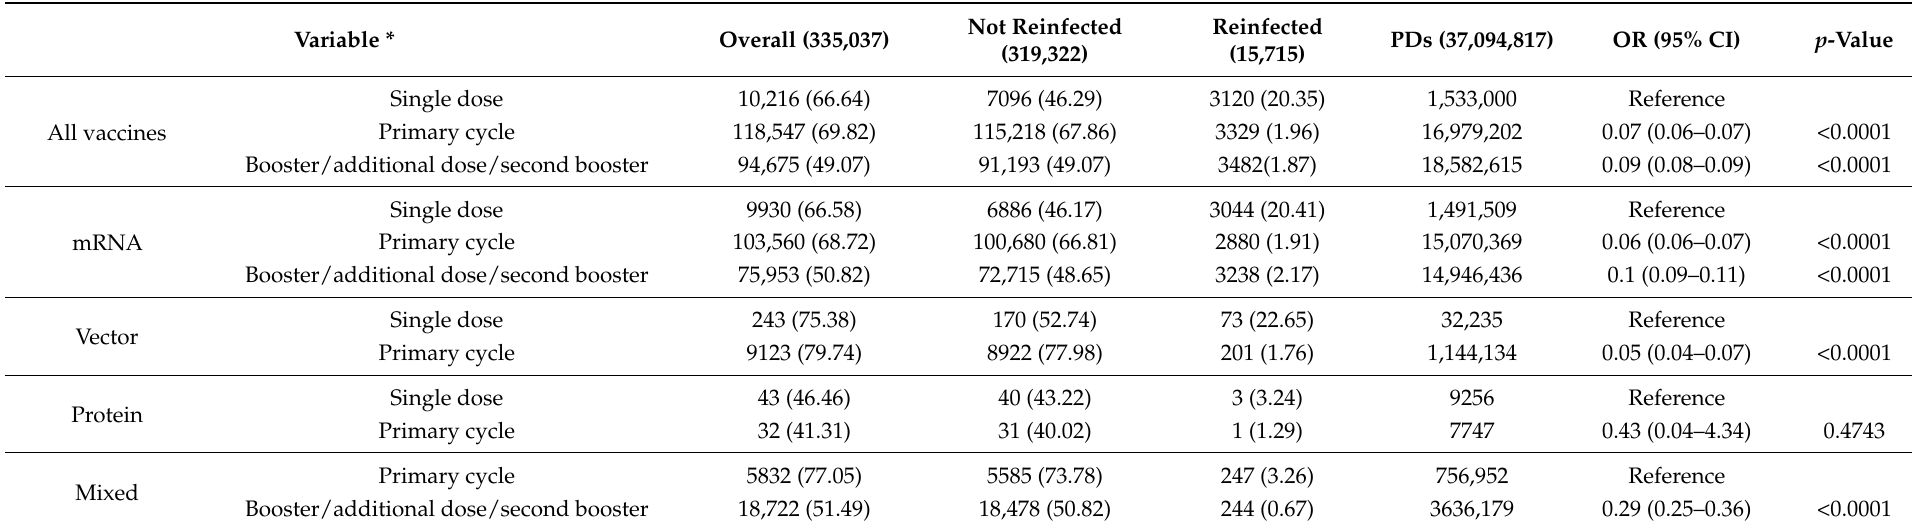
Table 2. Vaccinated individuals and odds ratios of SARS-CoV-2-reinfected individuals in